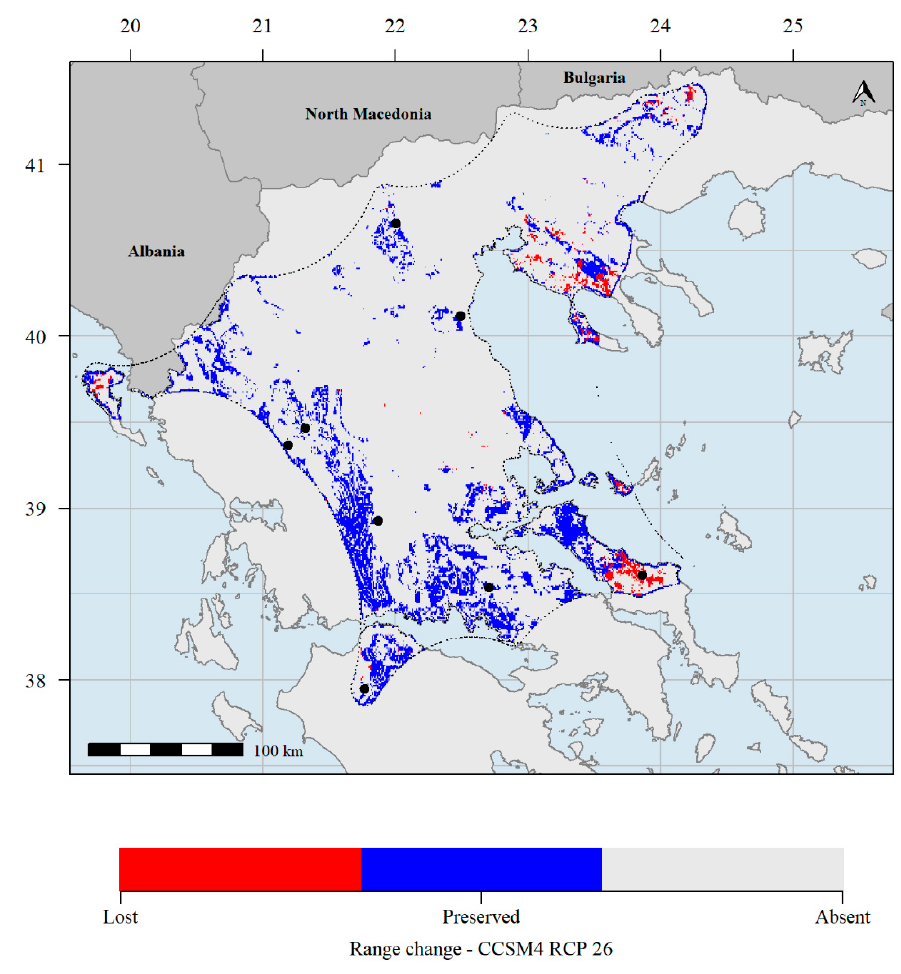
Figure 4. Predicted potential distribution map for 2070 and the CCSM4 GCM and the RCP 2.6 scenario. Red grid cells: the species currently occupies those areas but will not in the future. Blue grid cells: the species currently occupies those areas and will continue to occupy them in the future. Grey grid cells: the species does not currently occupy those areas and it will not occupy them in the future. The dotted line indicates the distribution area of Helleborus odorus subsp. cyclophyllus based on the alpha-hull method. Climate data refer to the WorldClim database.